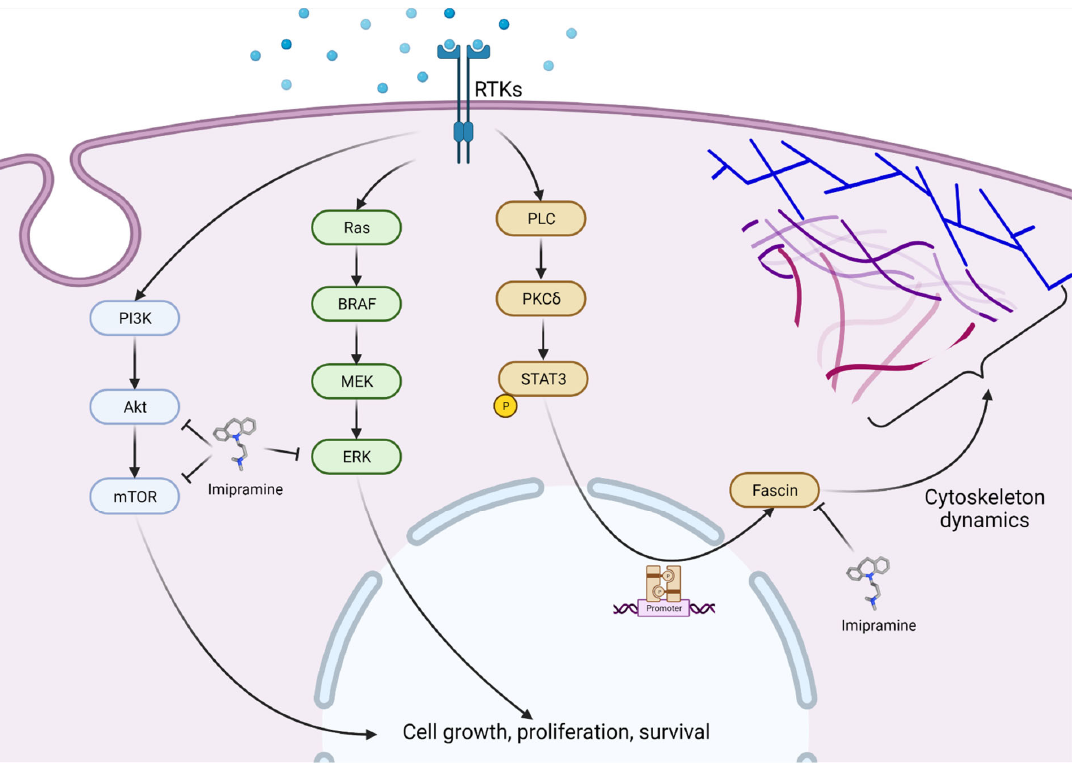
Figure 2. Relevant molecular pathways involved in the antitumoral mechanism of action of imi ‐ pramine. Imipramine inhibits the phosphorylation of Akt (Ser473) and mTOR (Ser2481) in a time ‐ dependent manner [57,80]. Imipramine is able to reduce the phosphorylation of ERK and P ‐ 65 NF ‐κ B, leading to inactivation of ERK/NF ‐κ B signaling transduction [55]. Imipramine can also in ‐ hibit the actin ‐ binding protein fascin. This inhibitory effect is mediated by direct binding of imi ‐ pramine to fascin [71]. Created with BioRender.com.